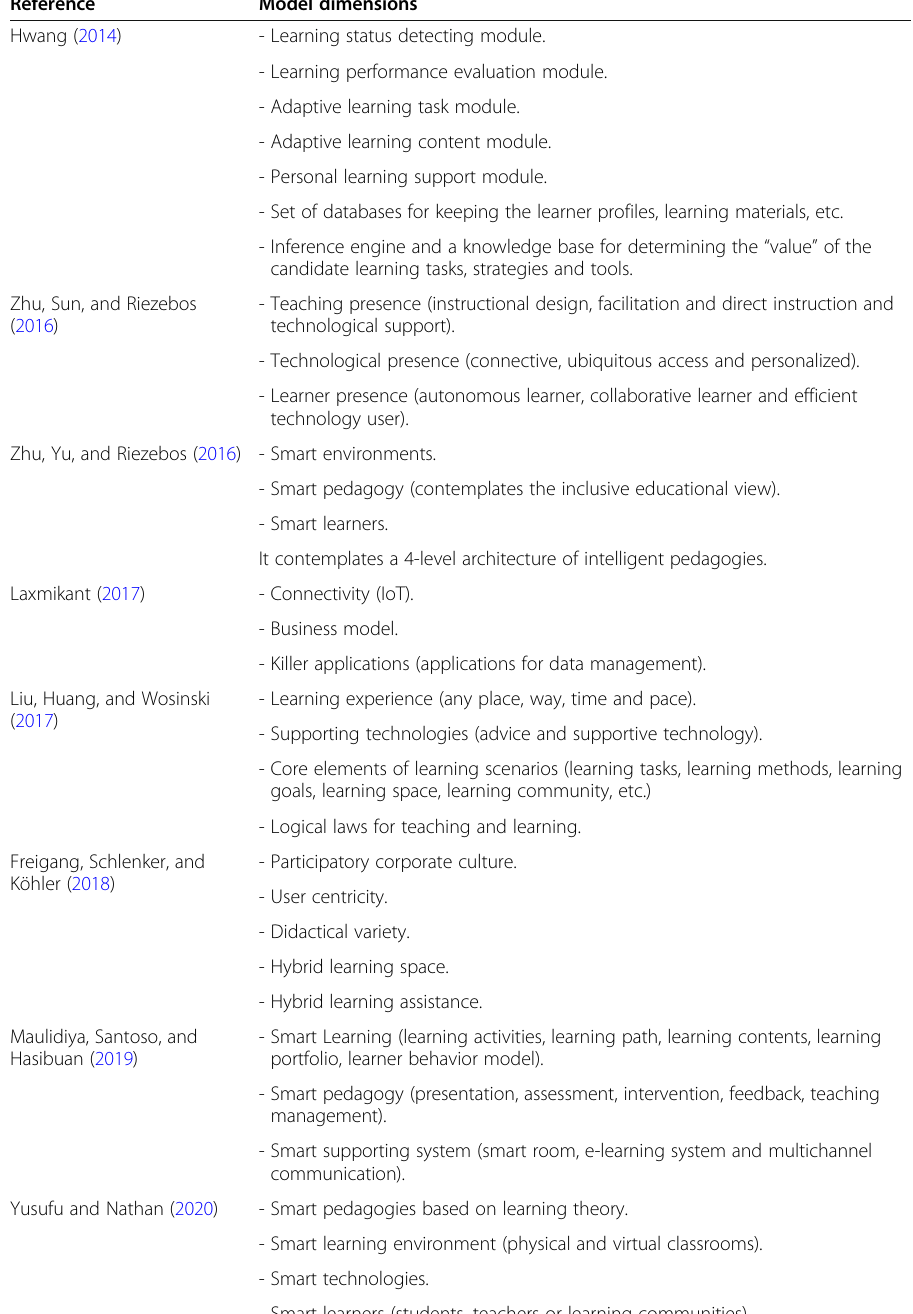
Table 2 SLE models or frameworks (chronologically ordered)